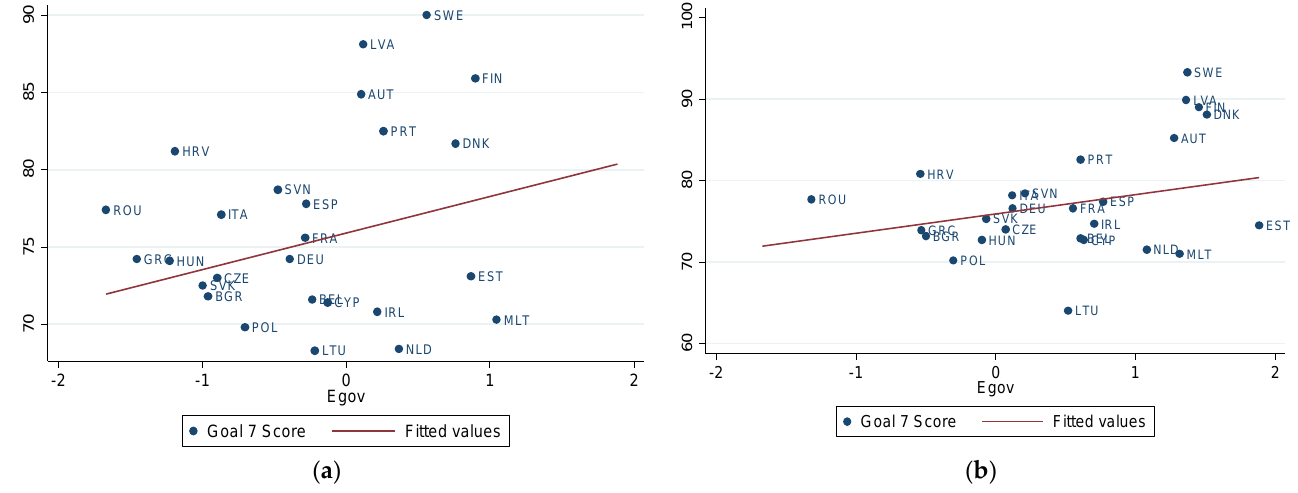
Figure 2. Scatter plot of e-government services development and SDG7 (affordable and clean energy) for EU countries for 2013 ( a ) and 2019 ( b ).